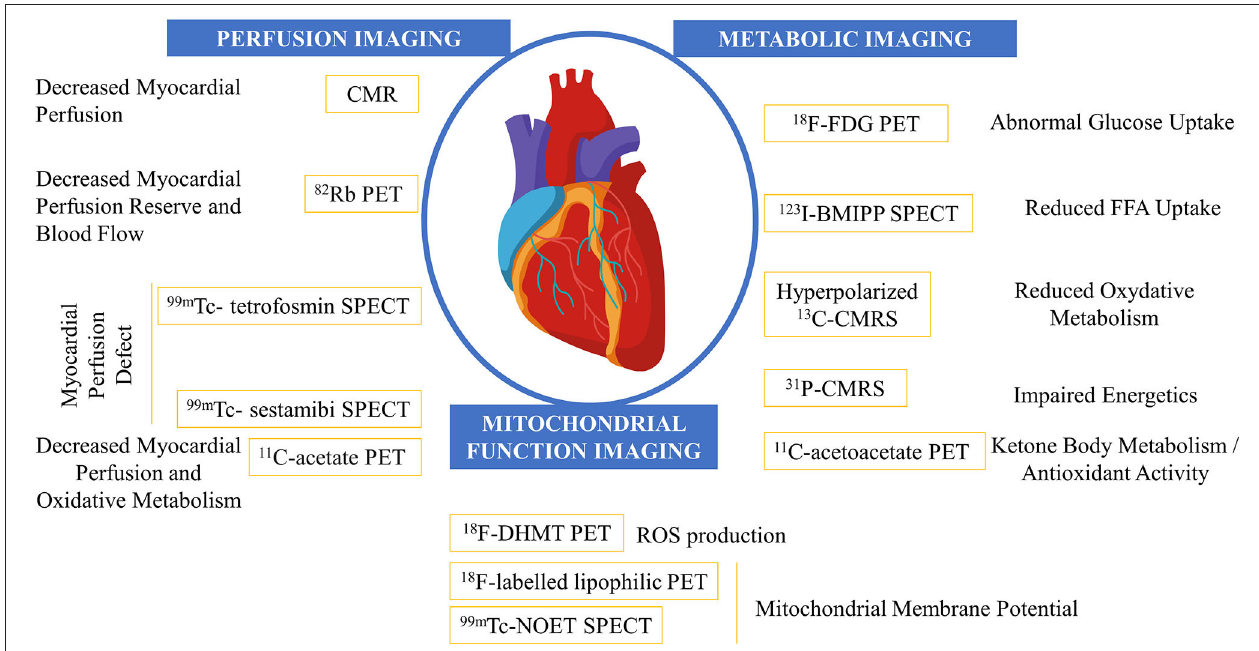
FIGURE 1 | Imaging modalities in the field of cardio-oncology and their assessment of anticancer-drug related cardiotoxicity. CMR, cardiac MRI; CMRS, cardiac magnetic resonance sprectroscopy; FDG, fluoro-D-glucose; FFA, free fatty acid; SPECT, single-photon emission